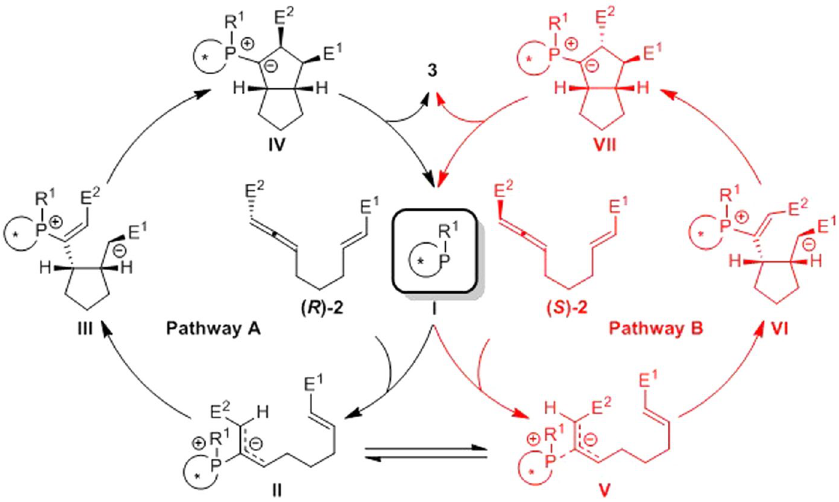
Figure 2. The proposed mechanism of binaphthophosphepine-catalyzed enantioselective intramolecular [3 + 2] cycloaddition of racemic allene ( ±